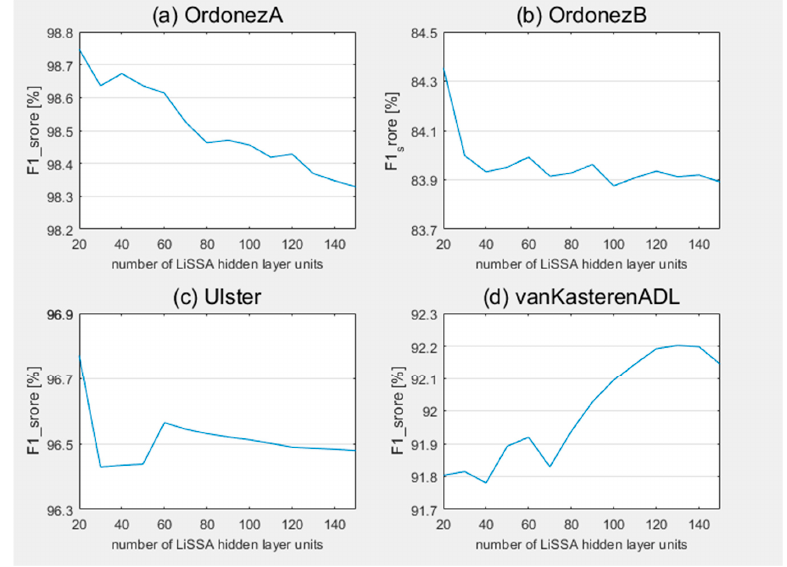
Figure 4. F1_score of proposed method with different number of LiSSA hidden layer units on datasets ( a ) OrdonezA, ( b ) OrdonezB, ( c ) Ulster, and ( d ) vanKasterenADL. ( a ) OrdonezA, ( b ) OrdonezB, ( c ) Ulster, and ( d )